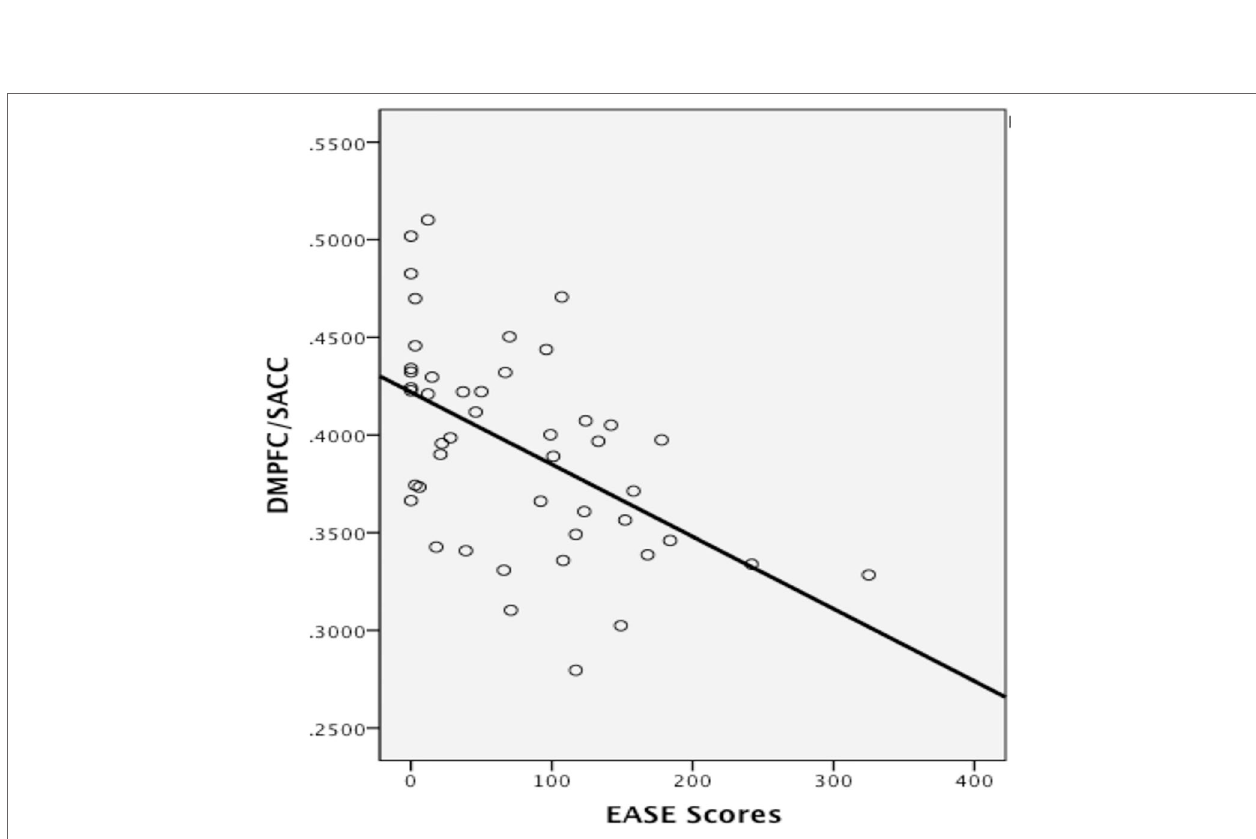
FIGURE 4 | Correlation between gray matter volume in the dorsomedial prefrontal (DMPFC)/supra-genual anterior cingulate cortex (ACC) cluster and levels of self- disturbances measured with the EASE. Values on the y -axis refer to mm 3 per